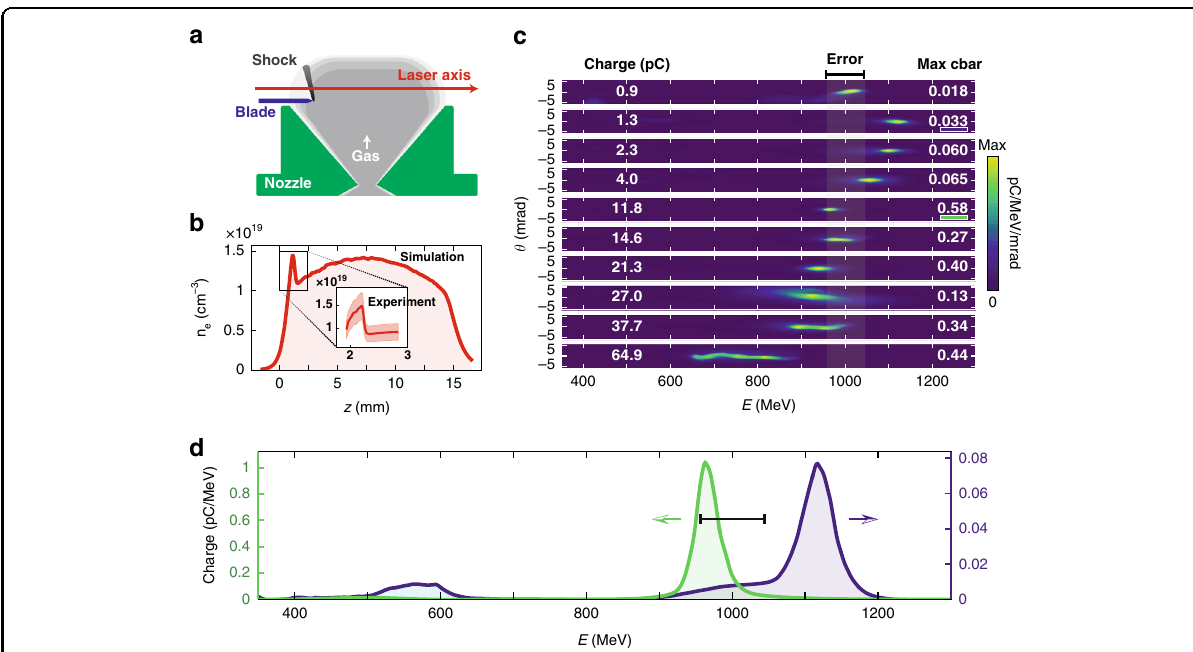
Fig. 4 Acceleration of high-quality electron beams with density transition injection. a Schematic view of the gas target. b Density pro fi le obtained from a fl uid simulation for our experimental parameters and measured density pro fi le in the shock region (inset). c Ten angularly resolved electron spectra sorted by charge (charge in the peak for d 2 N/dEd θ > 0.1( d 2 N/dEd θ ) max ). d Two examples of angularly-integrated spectra corresponding to spectra marked by blue and green lines in ( c ). The black segment indicates the uncertainty on the energy due to fl uctuations of beam pointing